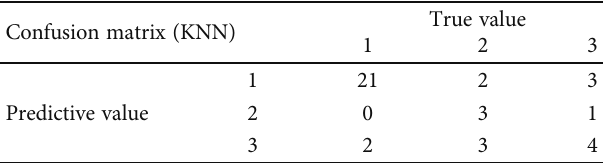
Table 2: Confusion matrix of results of K -nearest neighbor algorithm for predicting ROP grade.